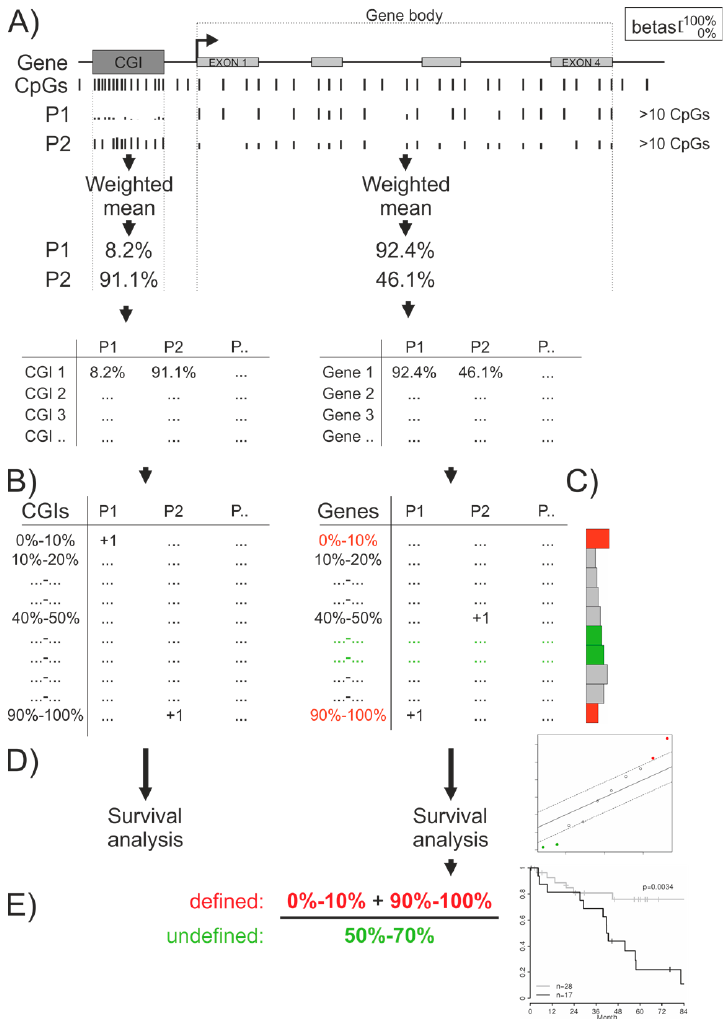
Figure 1. Overview of the generation of the global CpG island (CGI) and gene body (GB) methylation measures used for correlation with overall survival (OS). ( A ) Beta values from CpGs mapped to CGIs or GBs were averaged—from RRBS data with a weighted method—and ( B ) summarized in decile slots, ( C ) shown as a histogram exemplarily for the GBs of one patient. ( D ) Using these summarized decile numbers robust Cox regression analyses with censored OS data were performed (plot on the right showing the expected and observed scores for the ten deciles and the 5% false discovery rate (FDR) cutoff as dashed line; in red and green the significant deciles). ( E ) Using all negatively (red dots in the plot of (D)) and positively (green dots in the plot of (D)) with OS correlated deciles a methylation definition factor (MDF) was calculated as indicated and used for Cox regression analysis including known cancer type specific clinicopathologic parameters. An optimal cutoff for the MDF was determined from this model and a Kaplan–Meier estimate using the optimally dichotomized MDF is show on the right. A plot of the Cox model, corrected for clinicopathologic factors, is shown in Figure 2 and details of the Cox regression models are given in Table 1.